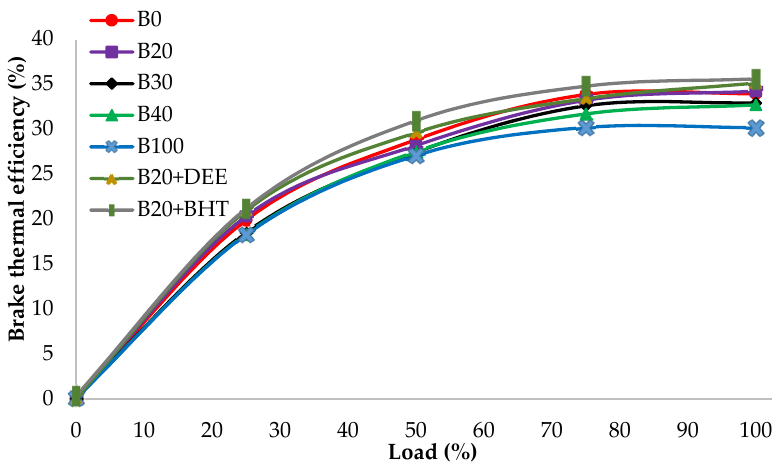
Figure 8. BTE of all fuel blends at different engine loads.